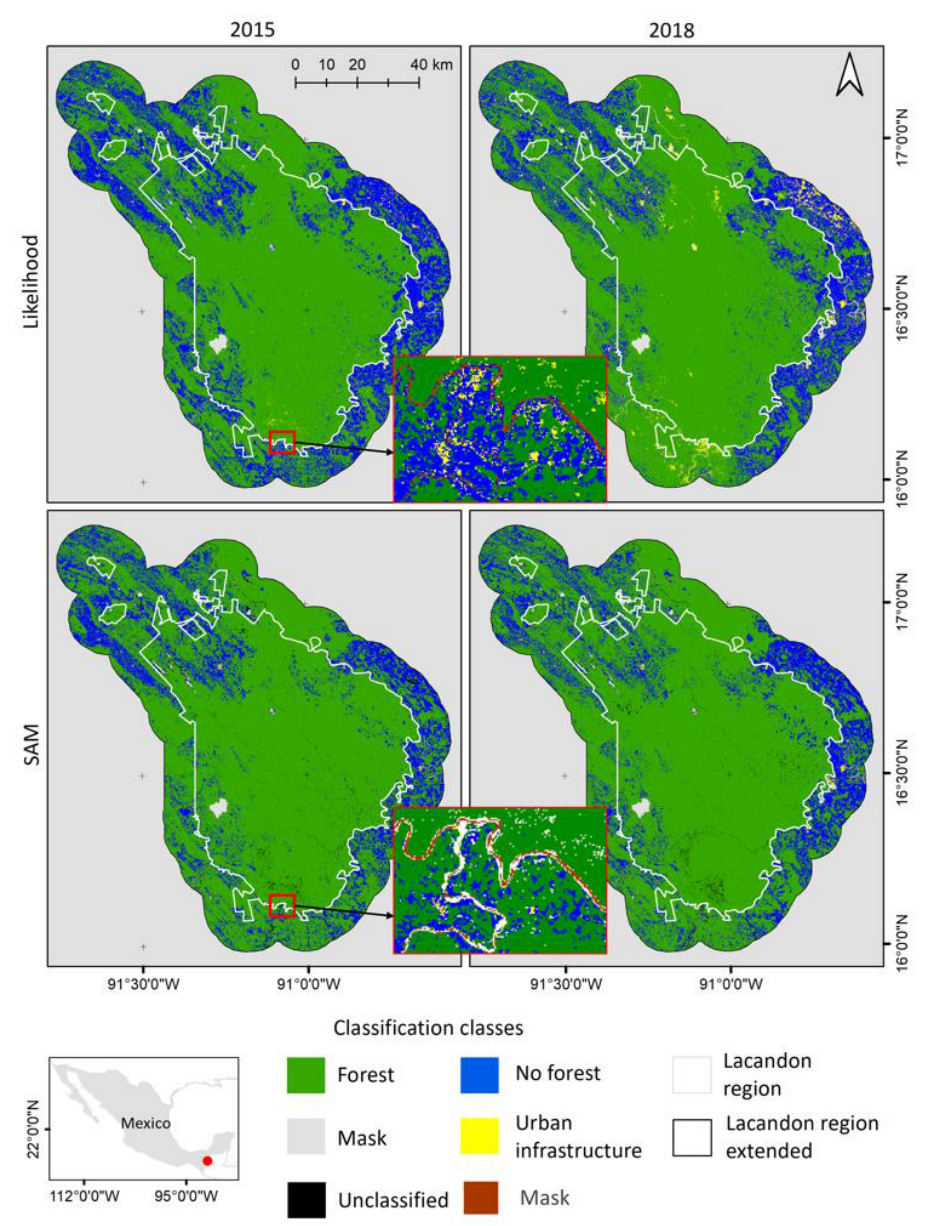
Figure 3. Distribution of the land use and land cover for the likelihood and SAM classifications (2015 and 2018) for the Lacandona and Lacandona extended regions, respectively. Rows: Maps of each tested algorithm; columns: years tested. The class forest is depicted in green; no forest in blue; urban infrastructure in yellow; non classified in black, and mask in gray. Thick line depicts the extended Lacandona region. Thin line depicts the Lacandona region. See Methods for details.